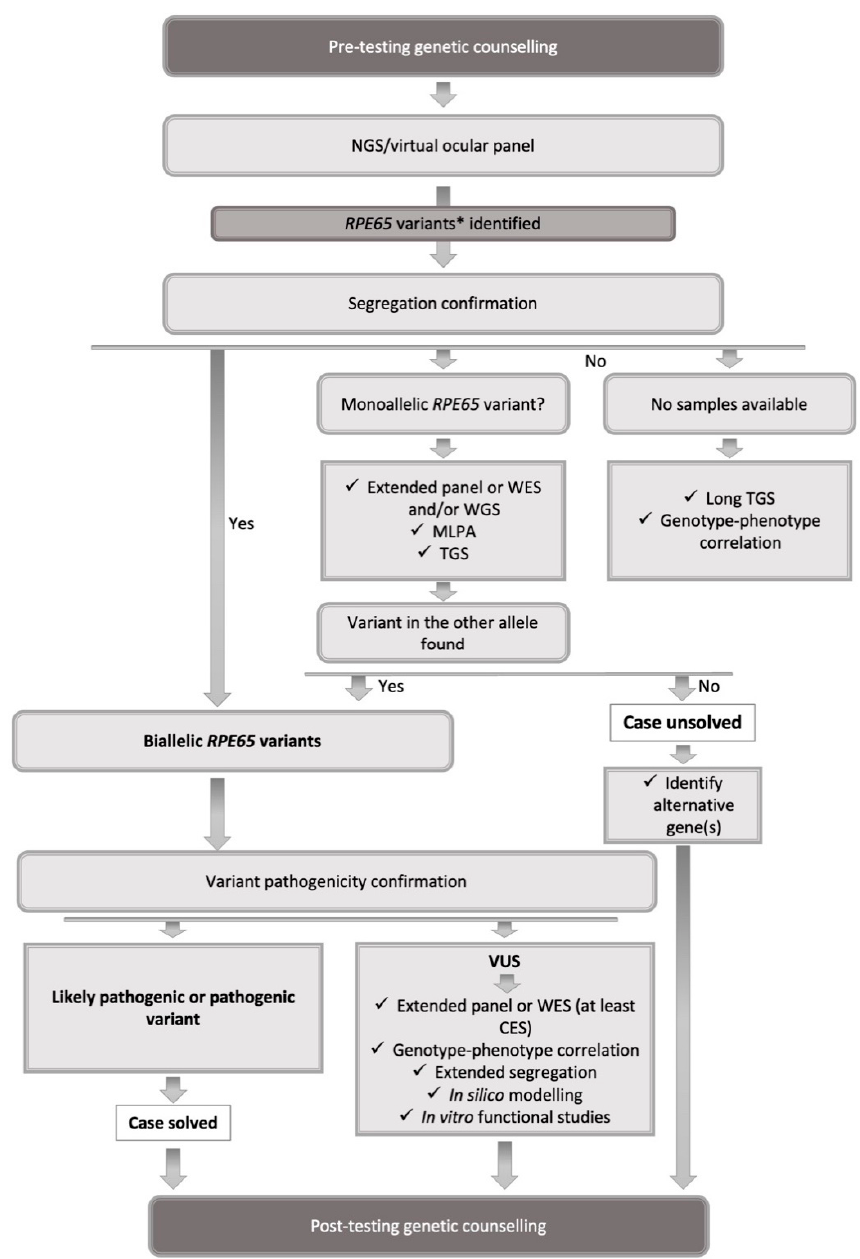
Figure 1. The summary of a proposed genetic diagnostic workup. * If benign or likely benign variants found, the search for a mutation(s) responsible for the phenotype should be extended to other genes. CES, clinical exome sequencing; MLPA, multiplex ligation probe amplification; NGS, next-generation sequencing; VUS, variant of uncertain significance; WES, whole-exome sequencing; WGS, whole-genome sequencing.